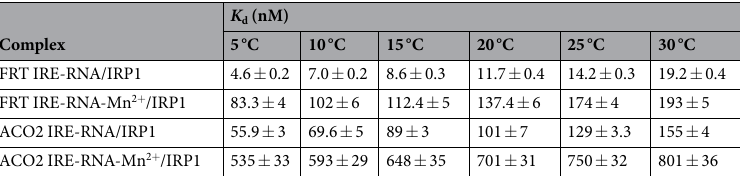
Table 1. Temperature dependent equilibrium dissociation constants ( K d ) for the interaction of FRT IRE-RNA and ACO2 IRE-RNA with IRP1 protein in the absence and presence of 50 µ M Mn 2 +